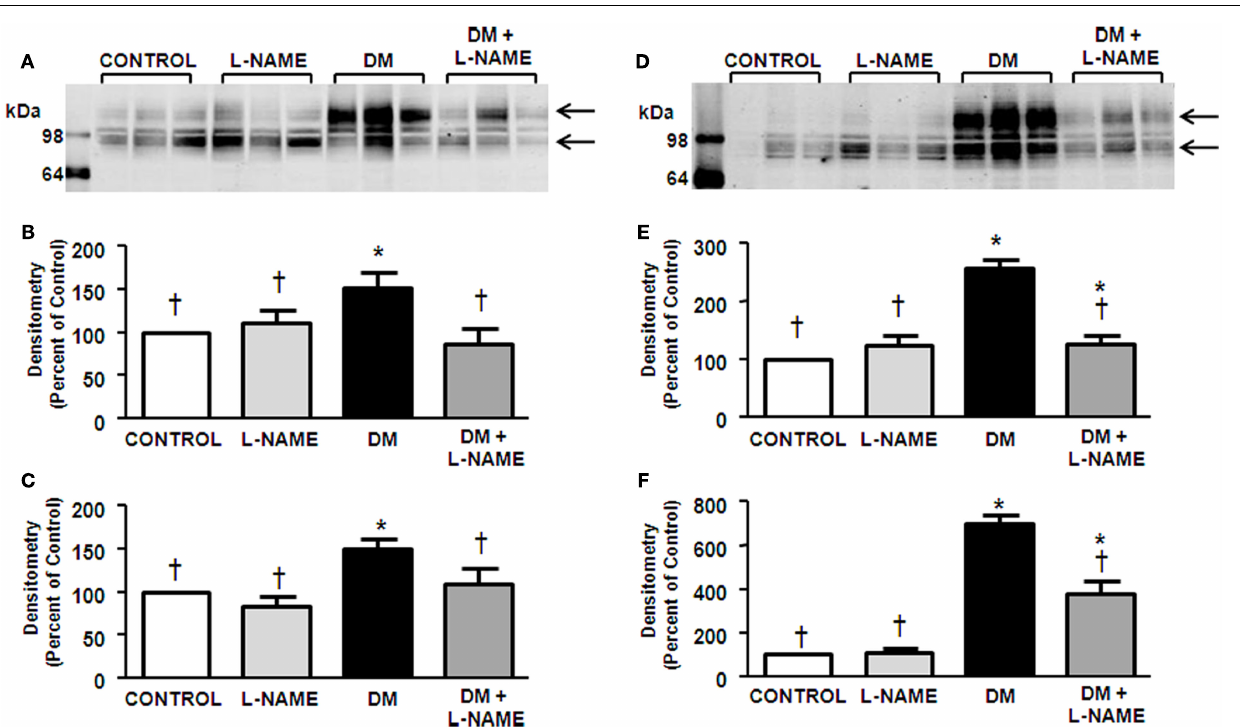
97-kDa (E) and 117-kDa glyco-forms (F) in IM base.The experimental conditions were performed 5 times ( n = 5) where there were 5 animals per experimental group in each cohort. In total, 25 animals per experimental group were analyzed. * p < 0.05 compared to control, † p < 0.05 compared to